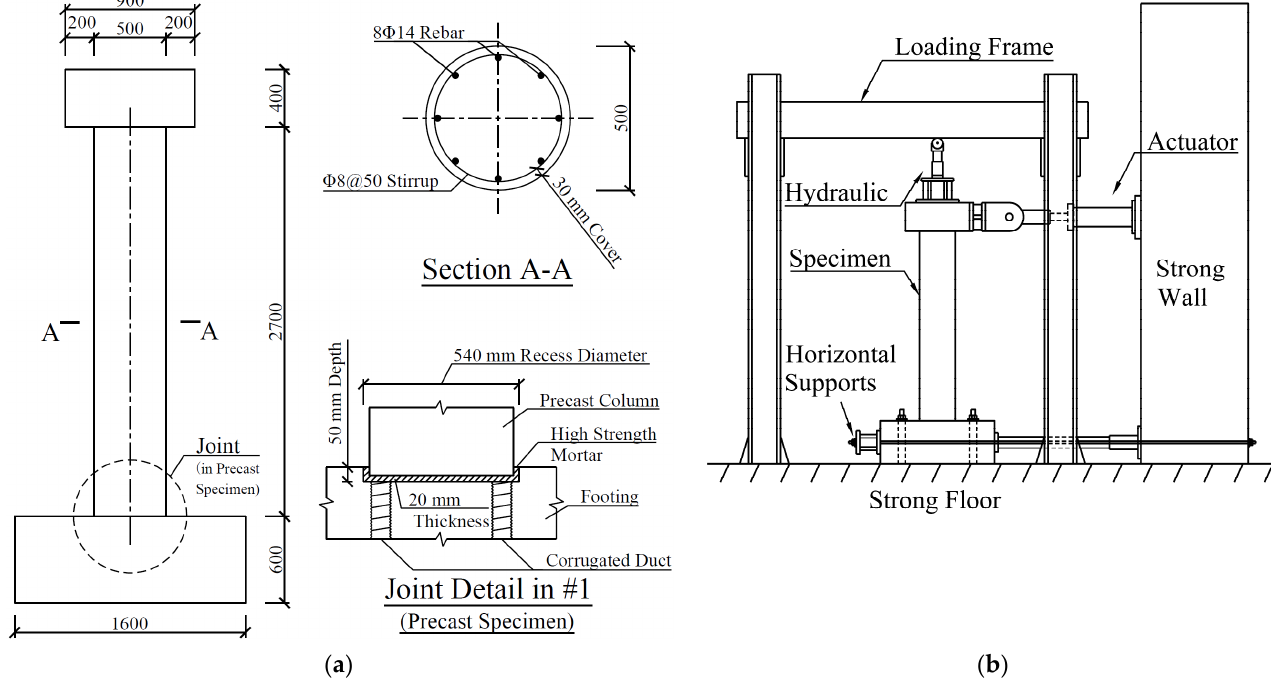
Figure 1. Test ( a ) specimen design (unit: mm); ( b ) setup